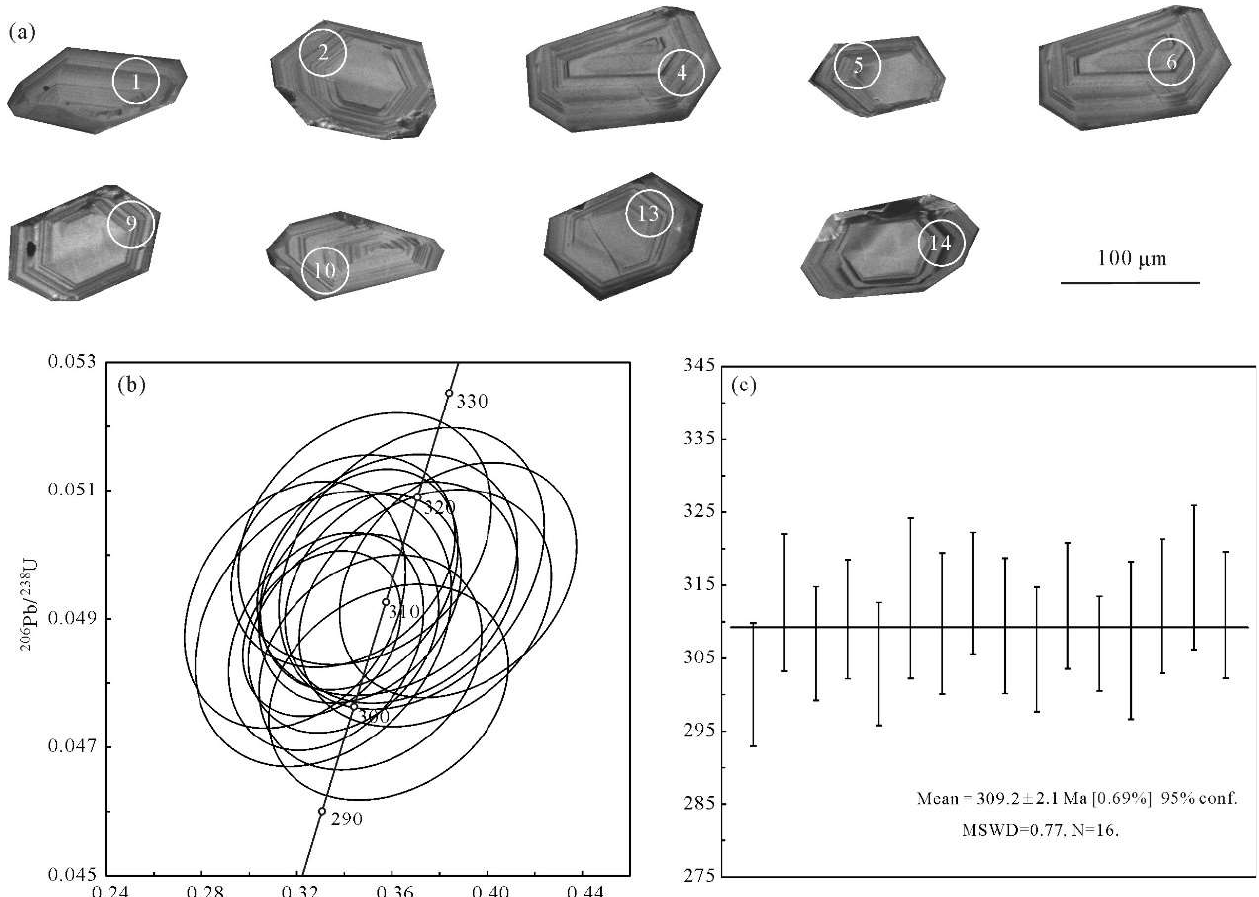
Figure 7. ( a ) Representative zircon CL images, ( b ) Concordia curves, and ( c ) weighted mean age of LA-ICP-MS U-Pb data for the Gaolihan trondhjemite.